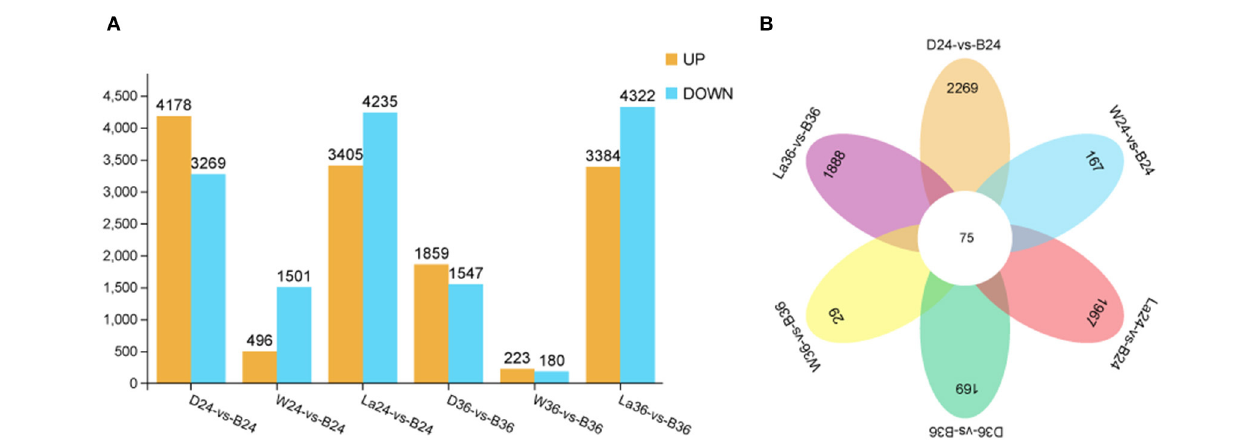
FIGURE 6 | Differentially expressed genes identified by RNA-seq analysis in hypocotyl of sprouts. (A) Number of DEGs between D vs B, W vs B, and La vs B groups at 24 and 36h after illumination. (B) Venn diagram representation of total genes from D, W, B, and La groups at 24 and 36h after illumination. D: dark. W: white light. B: blue light. La: blue light + 1mM LaCl 3 , 24 or 36h.